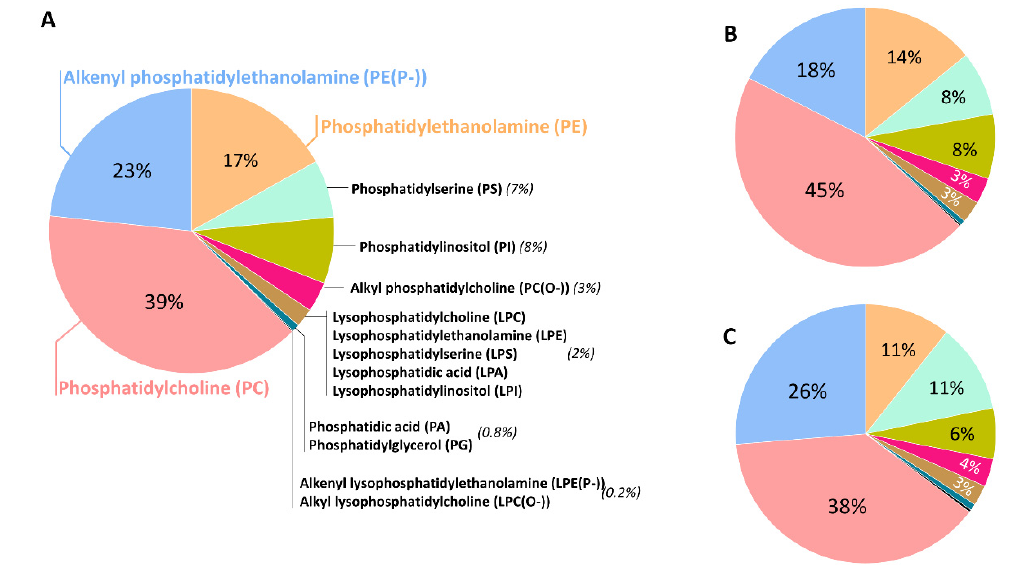
Figure 1. Glycerophospholipid distribution in the human prefrontal cortex ( A ), entorhinal cortex ( B ), and cerebellum ( C ) from healthy adult individuals. Lipidomic analysis was performed in a LC- MS/MS platform. Data obtained from reference [18].